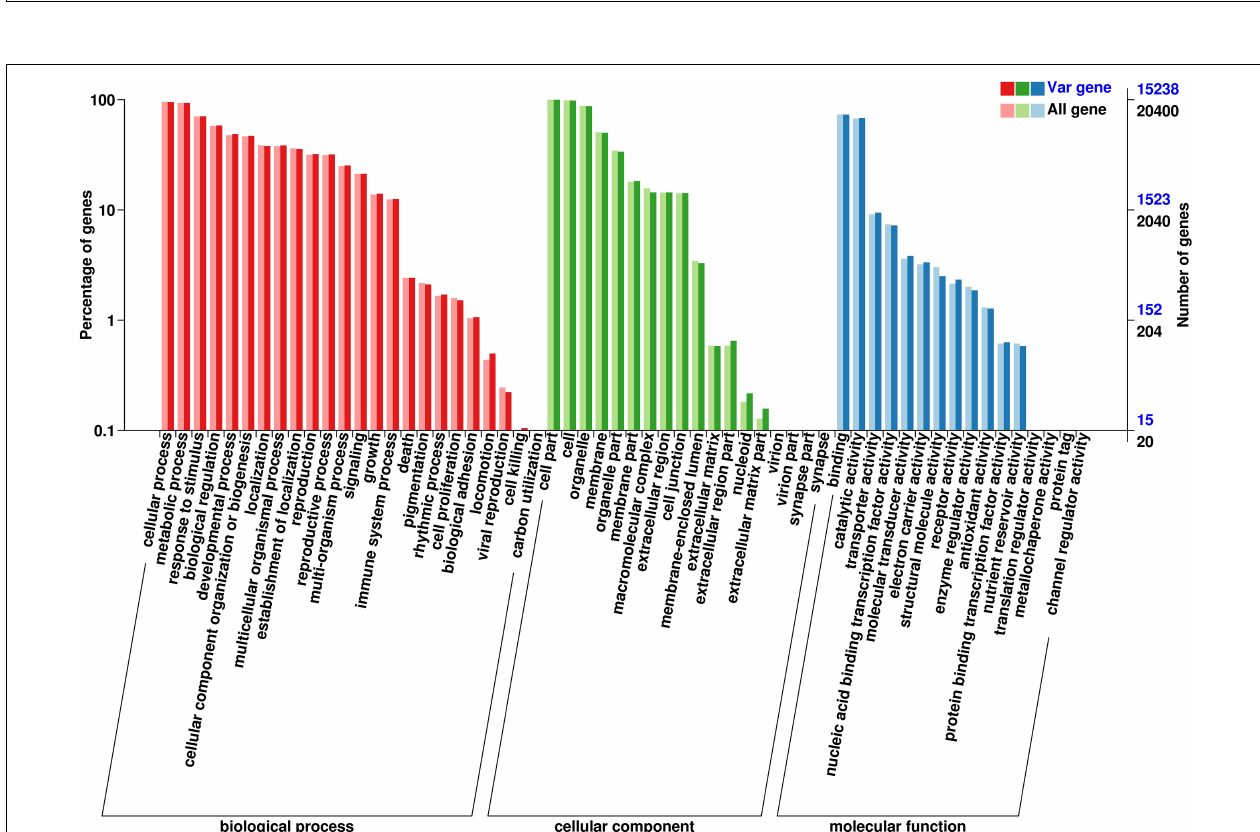
FIGURE 4 | Genetic diversity of 44 genomic SSR loci in four or six Munake cultivar accessions.